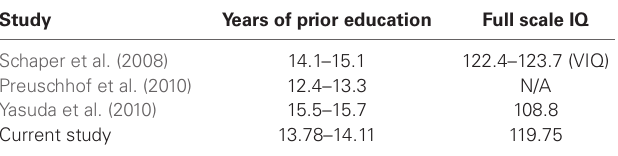
Table 4 | Comparison of the sample features in the present study to other